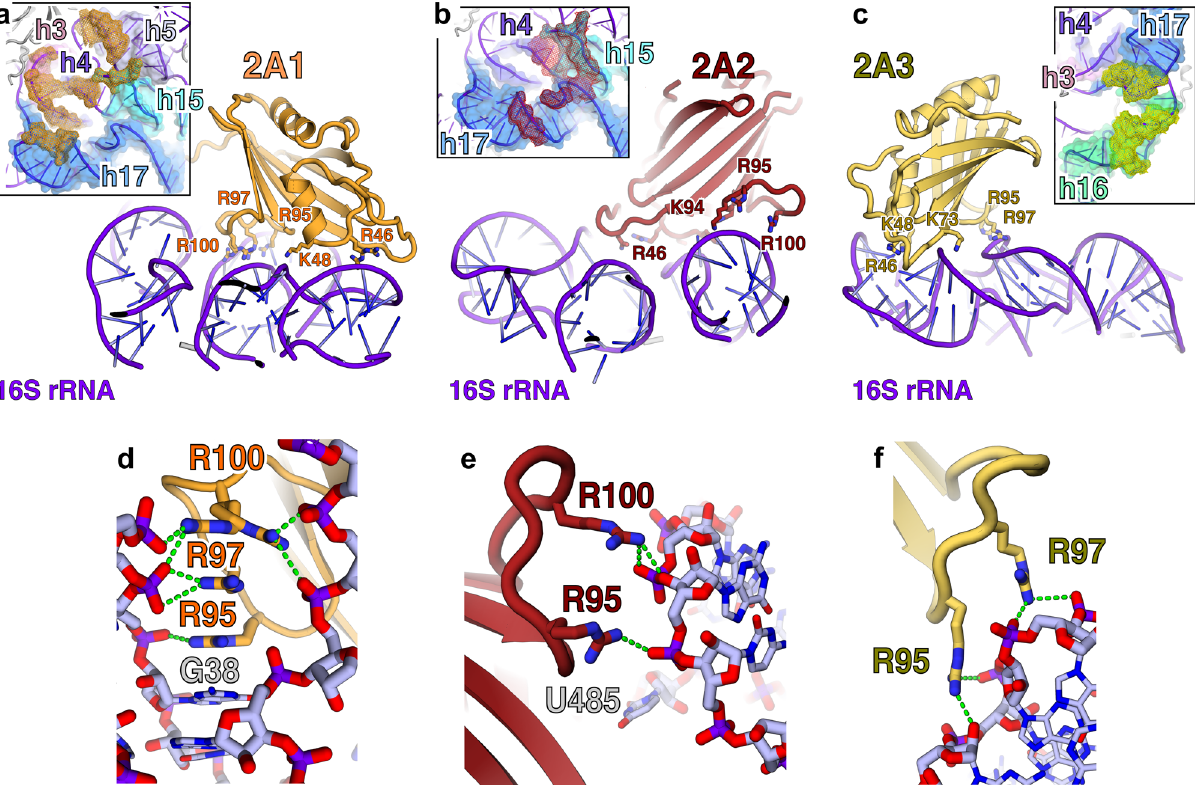
Fig. 6 The ‘ arginine loop ’ plays a central role in RNA recognition. a – c Details of rRNA recognition by 2A. For each copy of 2A, selected residues involved in interactions are labelled and shown as sticks. < Insets> View of the rRNA surface bound by each copy of 2A. The rRNA helices are colour-coded and labelled. The 2A contact surface is shown as a coloured mesh (orange, red and yellow, respectively). d – f , Close-up view of interactions between the 2A ‘ arginine loop ’ residues (R95, R97 and R100) and the rRNA backbone (sticks) for each copy of 2A (orange, red, yellow). Polar or electrostatic contacts are indicated by a green dashed RNA-binding surface can contribute to multiple functions through fi nely tuned relative af fi nities for different cellular targets.